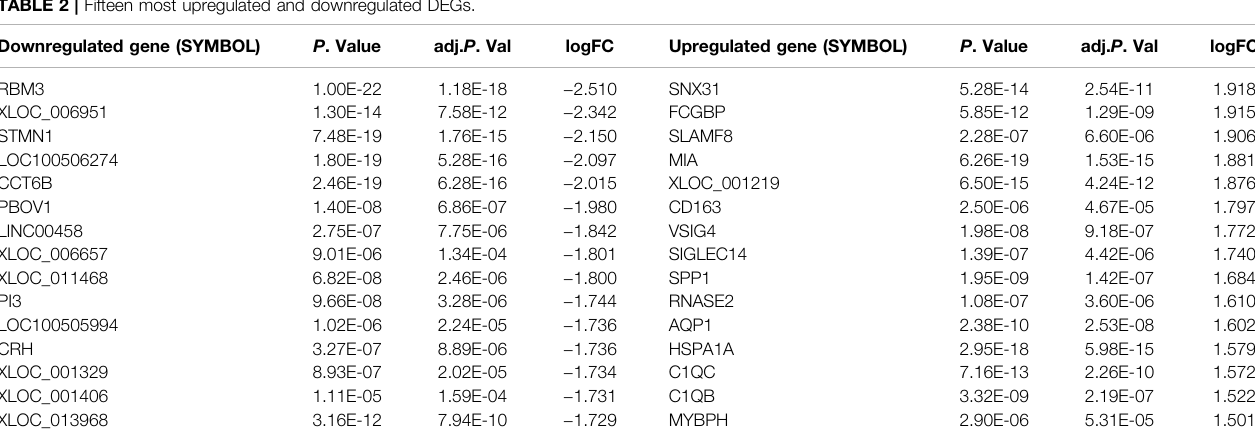
TABLE 2 | Fifteen most upregulated and downregulated DEGs. Downregulated gene (SYMBOL) P . Value adj. P . Val logFC Upregulated gene (SYMBOL) P . Value adj. P . Val logFC RBM3